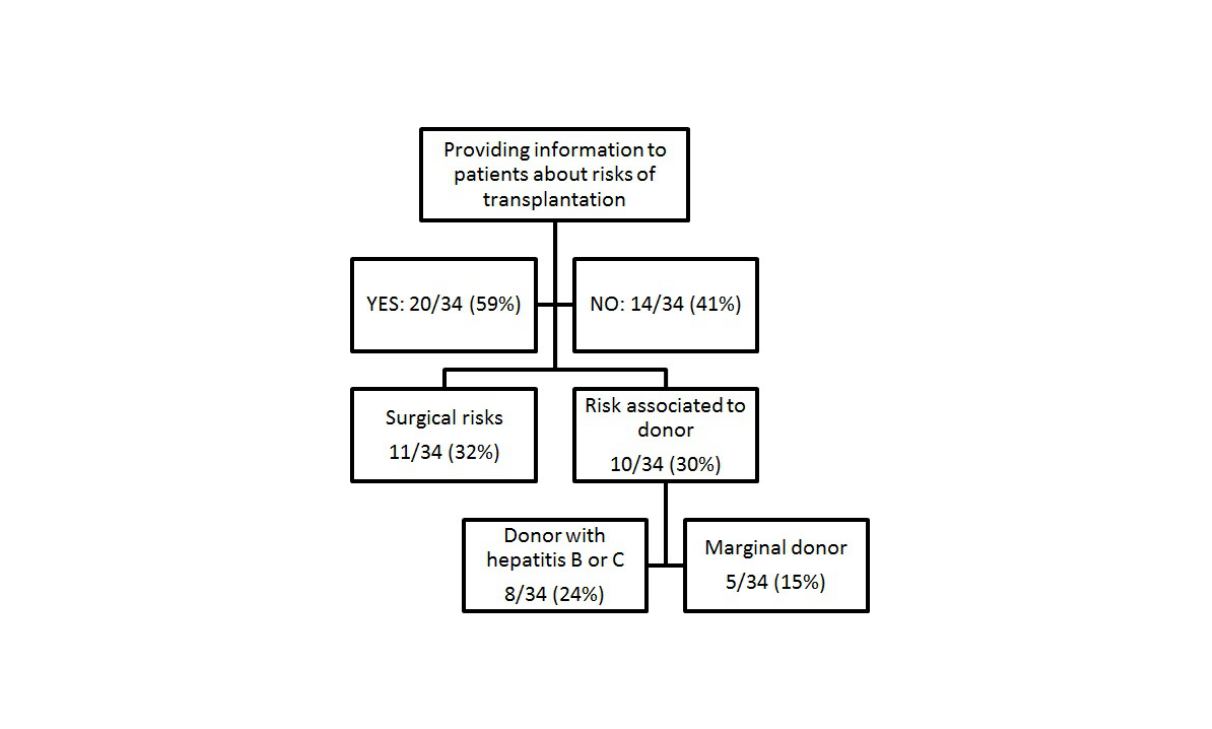
Figure 1. Flow chart of information proposed by associations to patients about the risks of